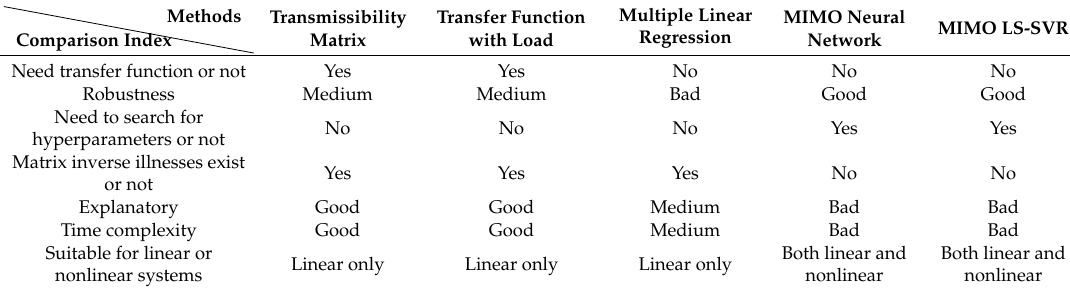
Table 1. Comparison of the di ff erent